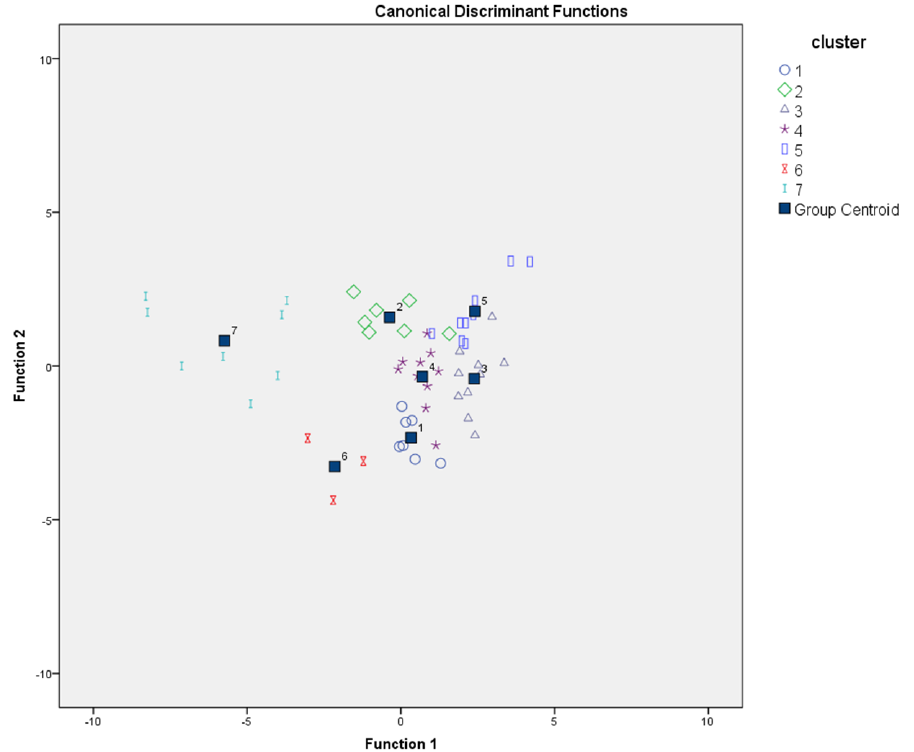
Figure 7. Canonical discriminant functions.